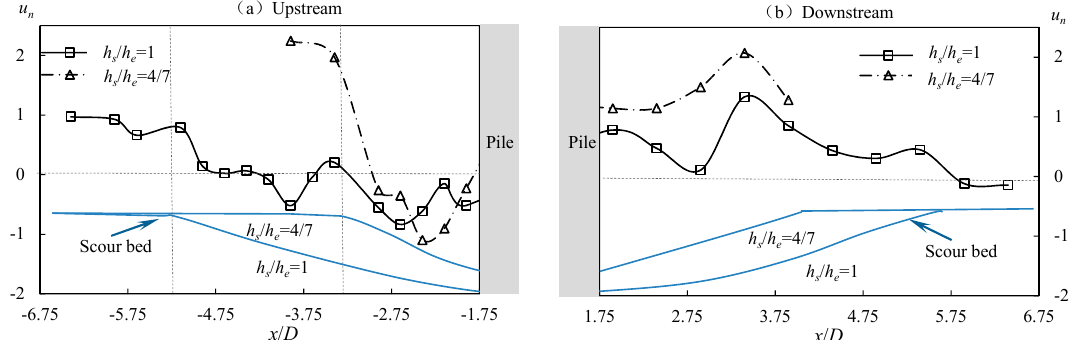
Figure 12. Distributions of bed shear velocity in the symmetry plane for ( a ) upstream and ( b ) downstream of the pile group.